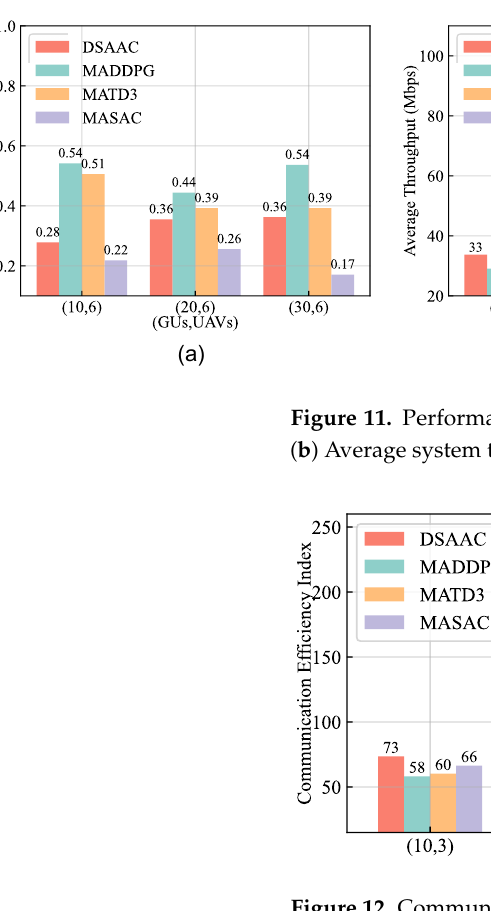
Figure 12. Communication efficiency index of